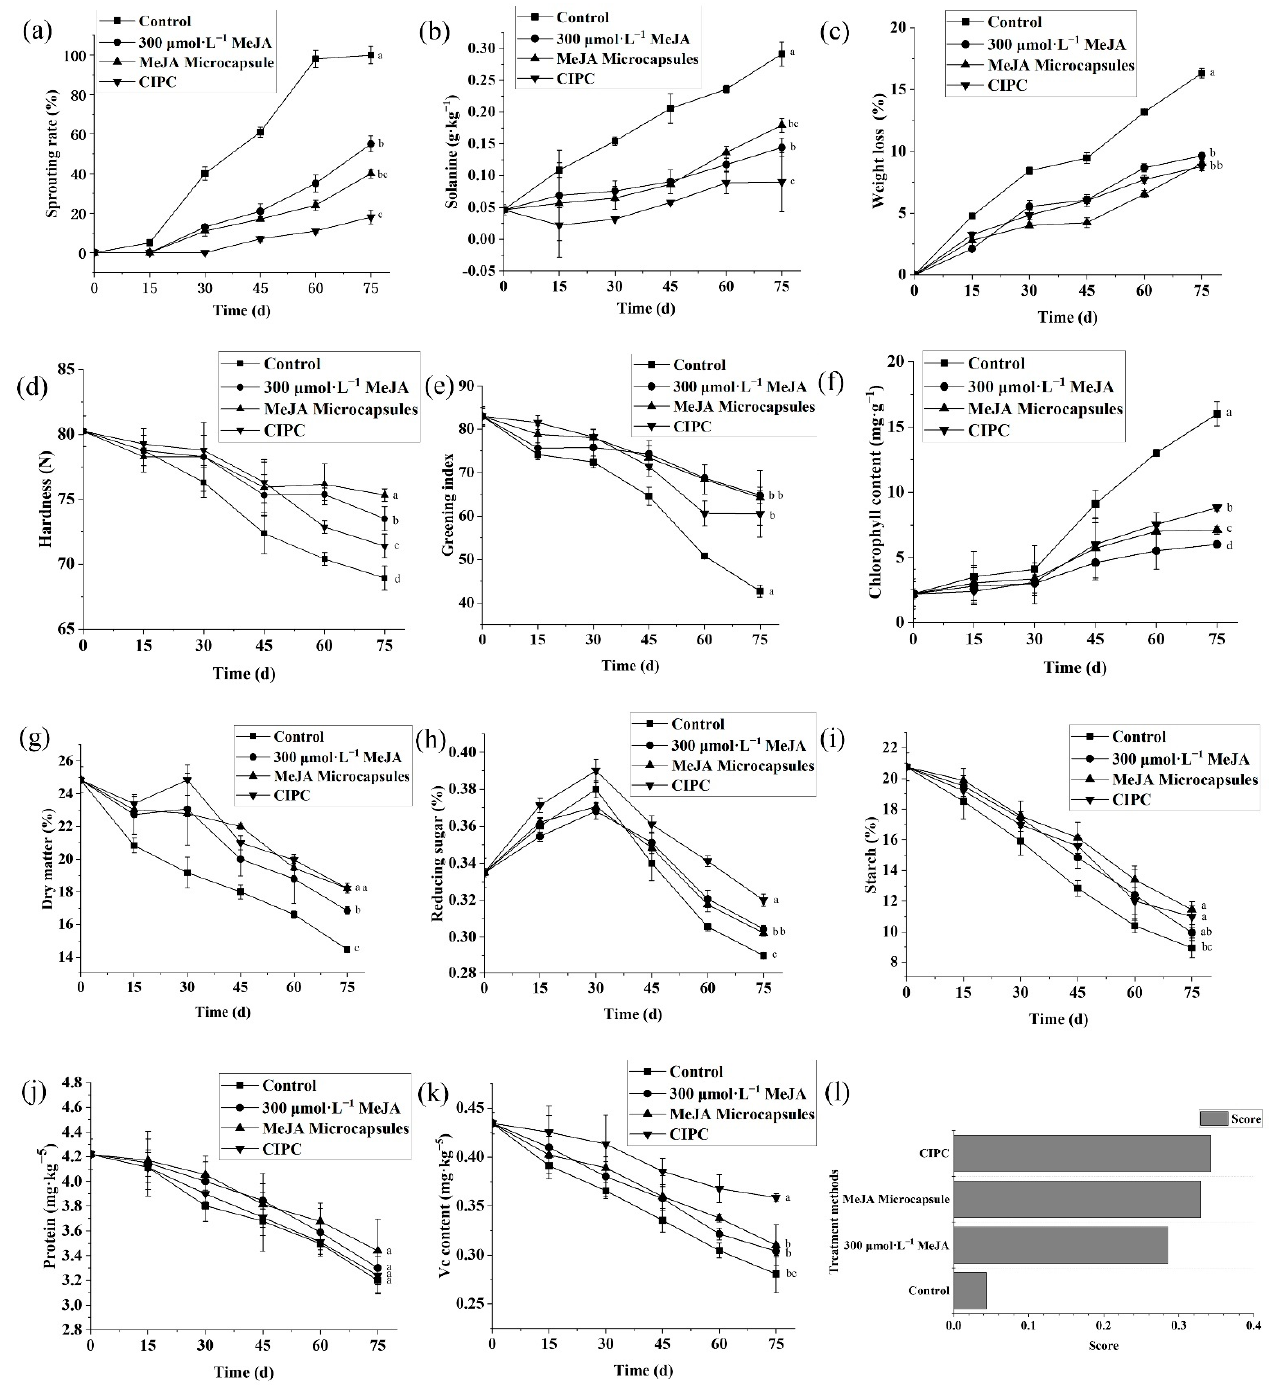
Figure 5. Methyl jasmonate microcapsules have high efficacy on the quality preservation of stored potato. Sprouting rates ( a ), solanine content ( b ), weight loss ( c ), hardness ( d ), greening index ( e ), chlorophyll content ( f ), dry matter ( g ), reducing sugar content ( h ), starch content ( i ), protein content ( j ), vitamin C content ( k ); TOPSIS score of the treatments based on these criteria ( l ). Note: control was treated with blank microcapsules. Multiple comparisons of the treatments using Turkey’s method ( p < 0.05) have been conducted after 75 d of storage, and treatments with no letters in common are significantly different.